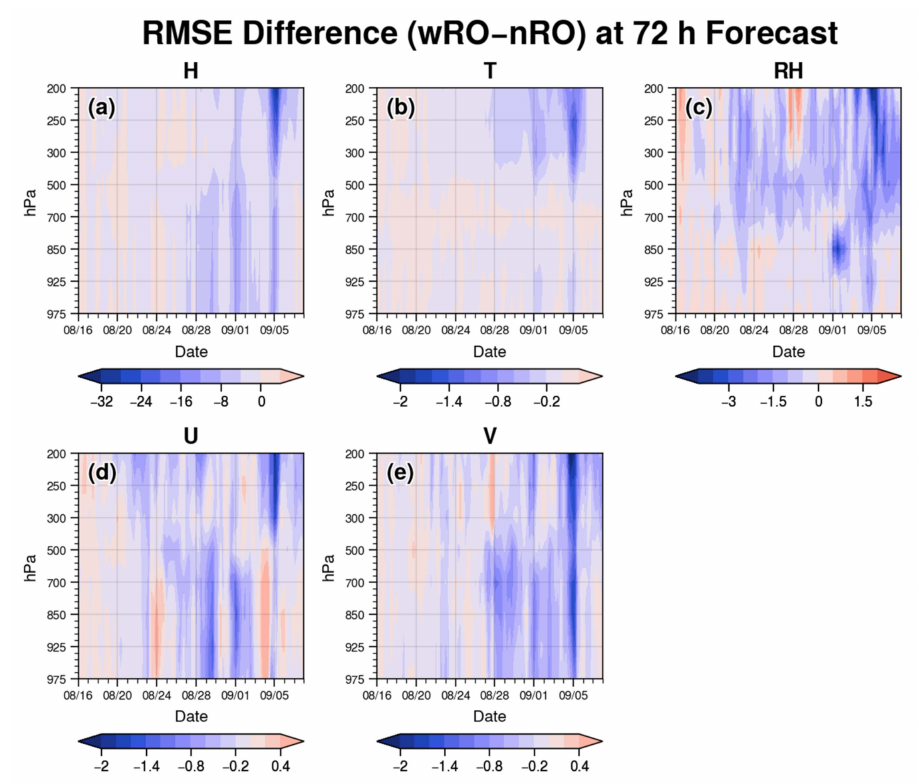
Figure 8. RMSE difference of 72-h forecast grid verification between nRO and wRO against 0.25 ◦ × 0.25 ◦ NCEP GFS analysis. The vertical profiles vary with the 93 initial time during the experiment period in ( a ) geopotential height (H, unit: meter), ( b ) temperature (T, unit: K), ( c ) relative humidity (RH, unit: %), and ( d ) u and ( e ) v wind speed (U and V, unit: m/s),